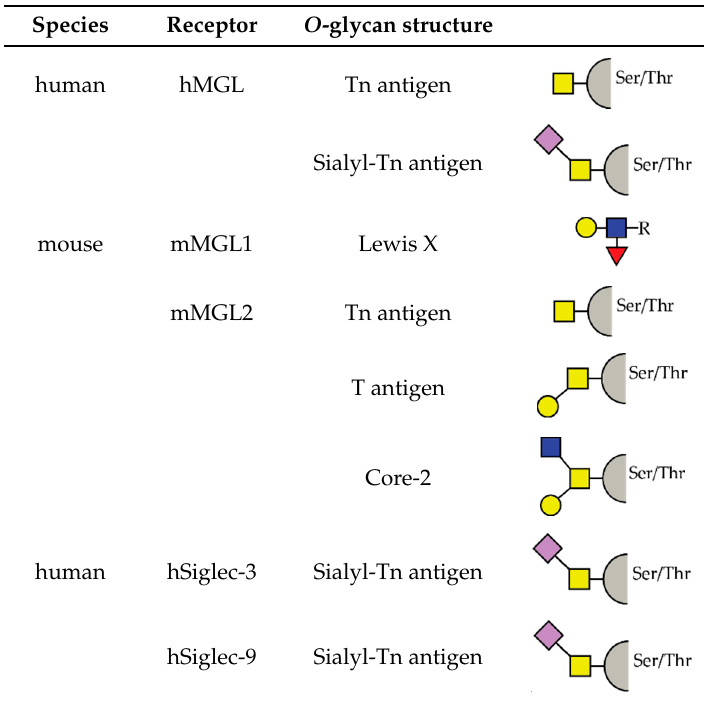
Table 1 . Immune receptors involved in the recognition of tumor ‐ associated O ‐ glycans.